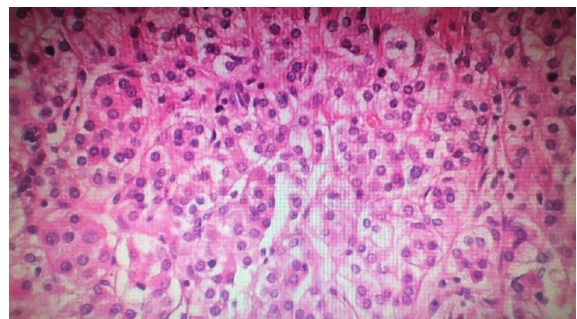
Figure 2: Histopathology of the adrenal mass. Polygonal cells with abundant granular amphophilic cytoplasm arranged in well-de- fined nests (zellbalen